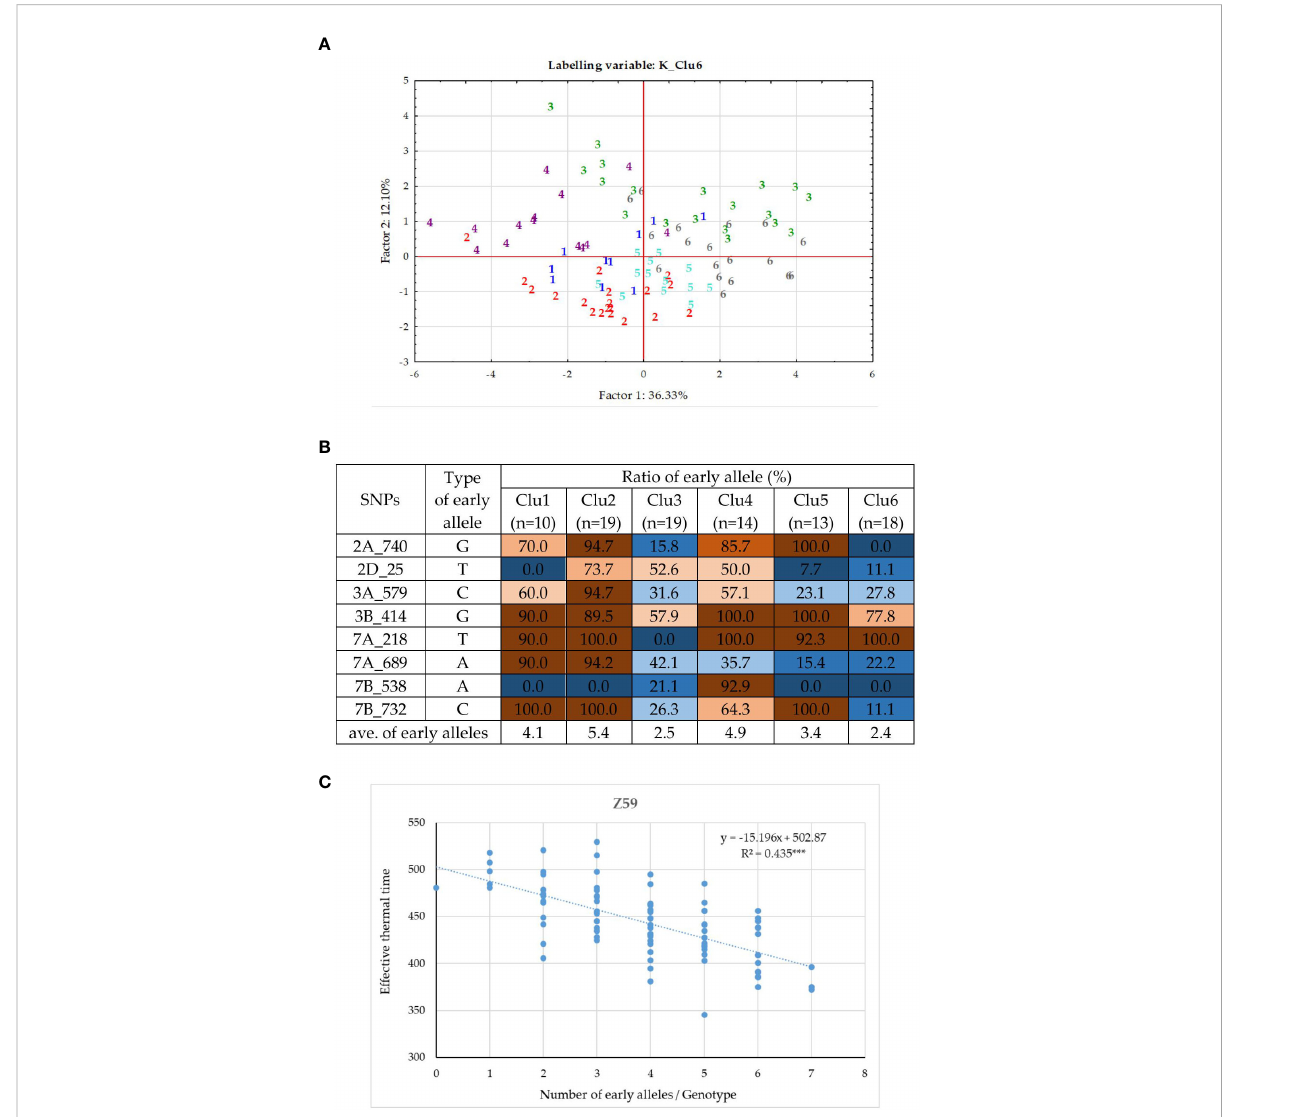
FIGURE 8 Inner structure of the PPD-D1 sensitive group of 93 wheat cultivars. (A) PCoA on the data matrix of the means of the fi ve consecutive developmental stages and eight signi fi cant SNPs de fi ning plant development, (labelled by the cluster positions from the K-mean clustering protocol). (B) Allele compositions of the six K-mean clusters in the eight SNPs de fi ning earliness. (C) Associations between the number of early alleles and heading